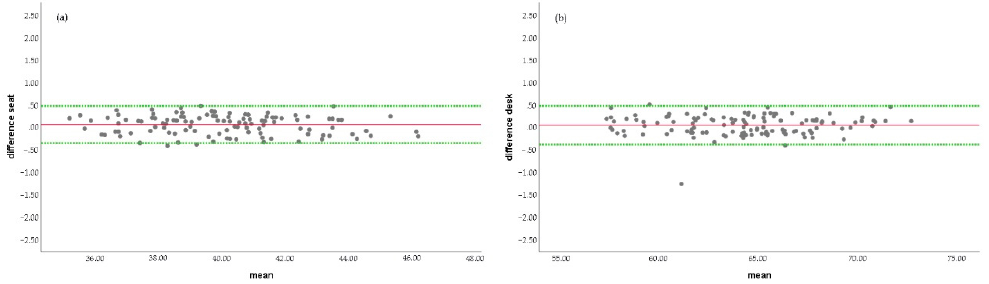
Figure 3. Correlational analysis between the ideal height of the chair calculated with an anthropometer and the ideal height of the chair with ISHT ( a ), and correlational analysis of the ideal height of the desk calculated using the anthropometer and ideal height of the desk using IDHT ( b ).